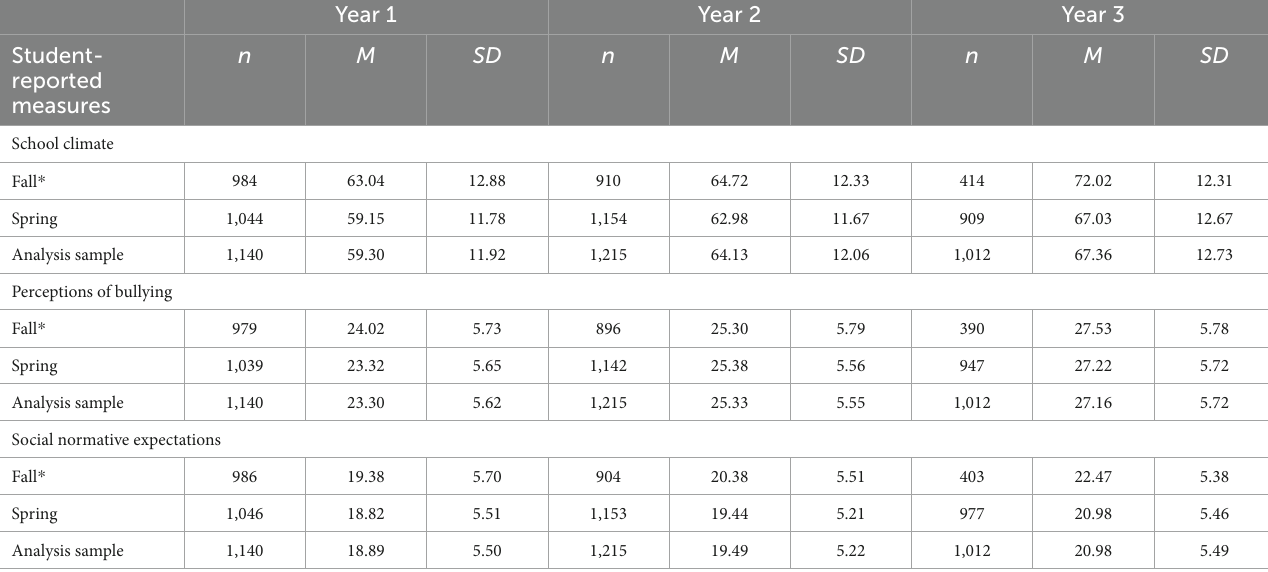
TABLE 4 Student perceptions of social emotional learning environment by